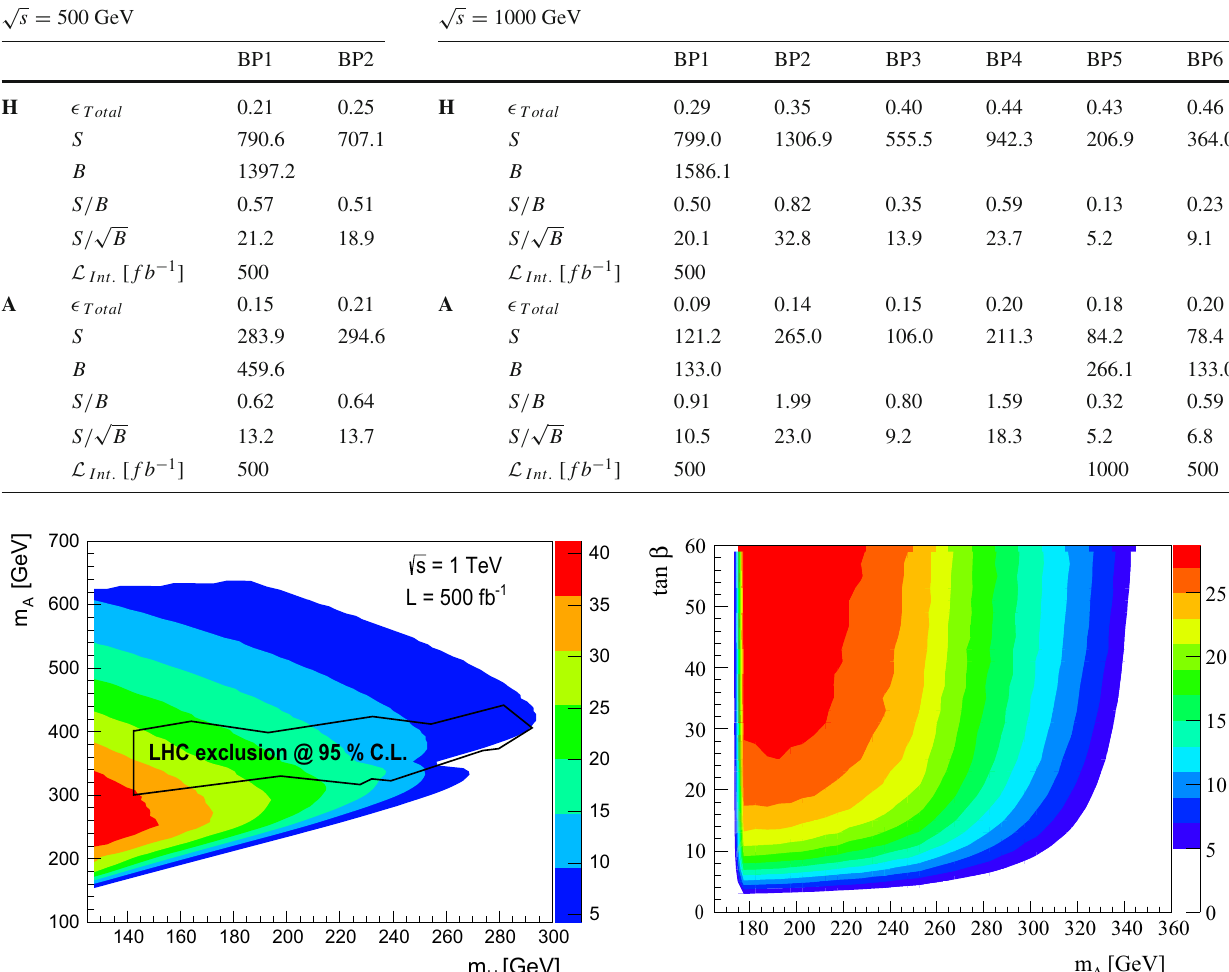
(b) The signal significance in ( m A , tan β ) plane with m H = m A − 50 GeV.